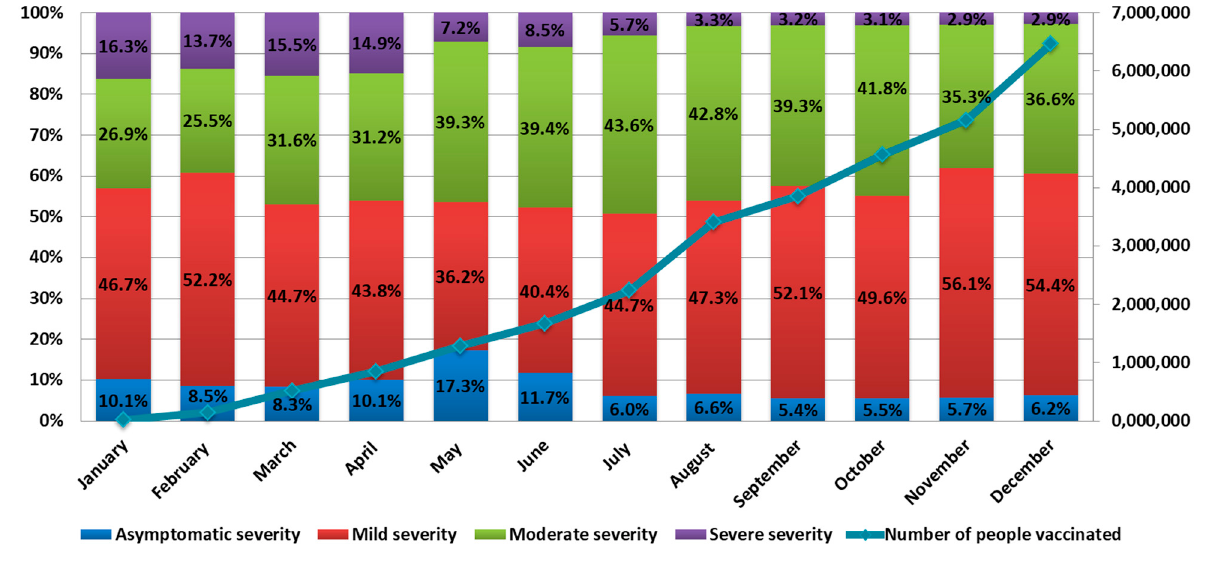
Figure 3. COVID-19 clinical severity and the number of vaccinated individuals in 2021. Concurrent with a substantial rise in the number of vaccinated individuals, the number of severe cases decreased by more than fivefold. Figure based on Rospotrebnadzor data.